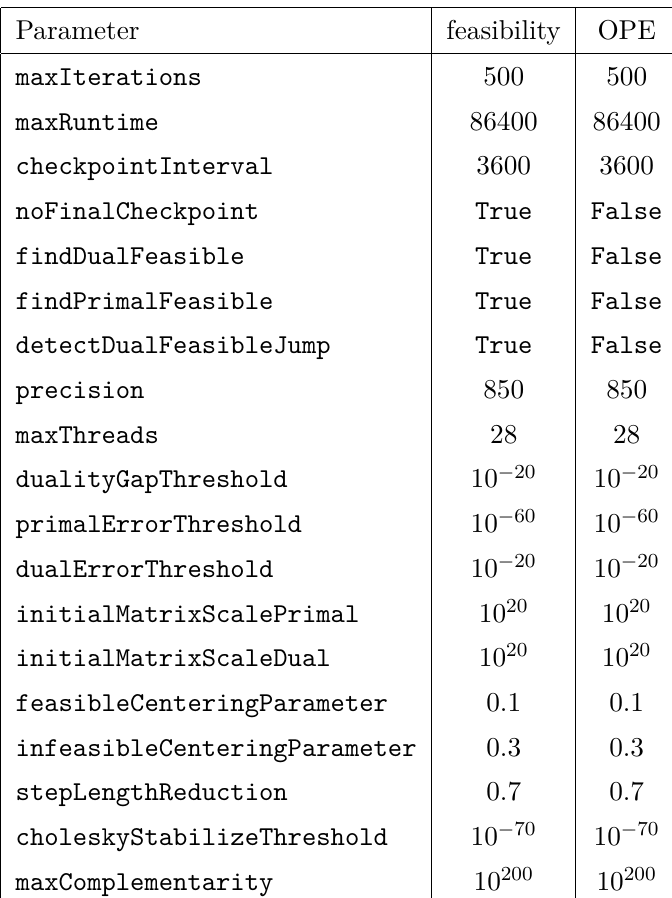
Table 4. Parameters used in sdpb for the feasibility problem used in the binary search or grid search (feasibility) and for the OPE coefficient maximization or minimization (OPE).